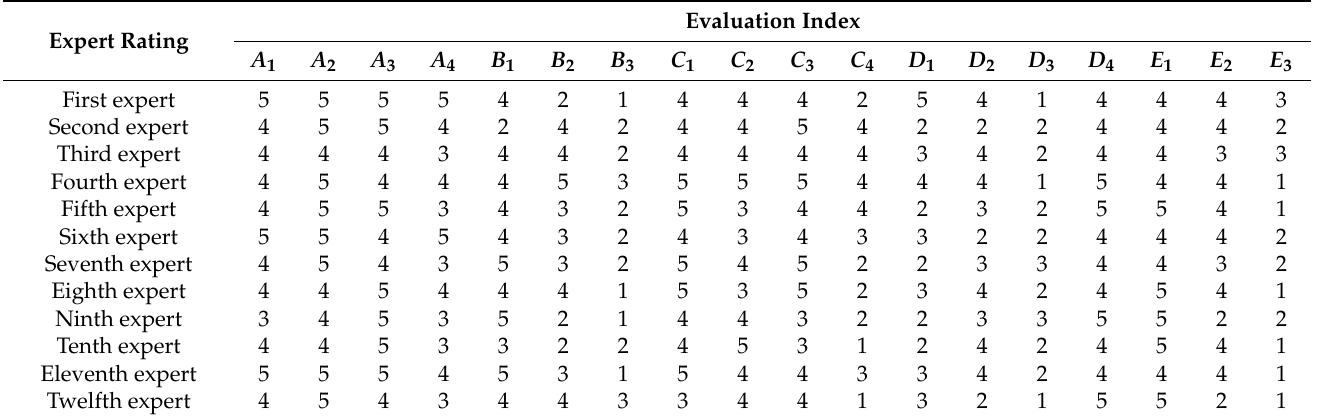
Table 3. Expert rating scale.